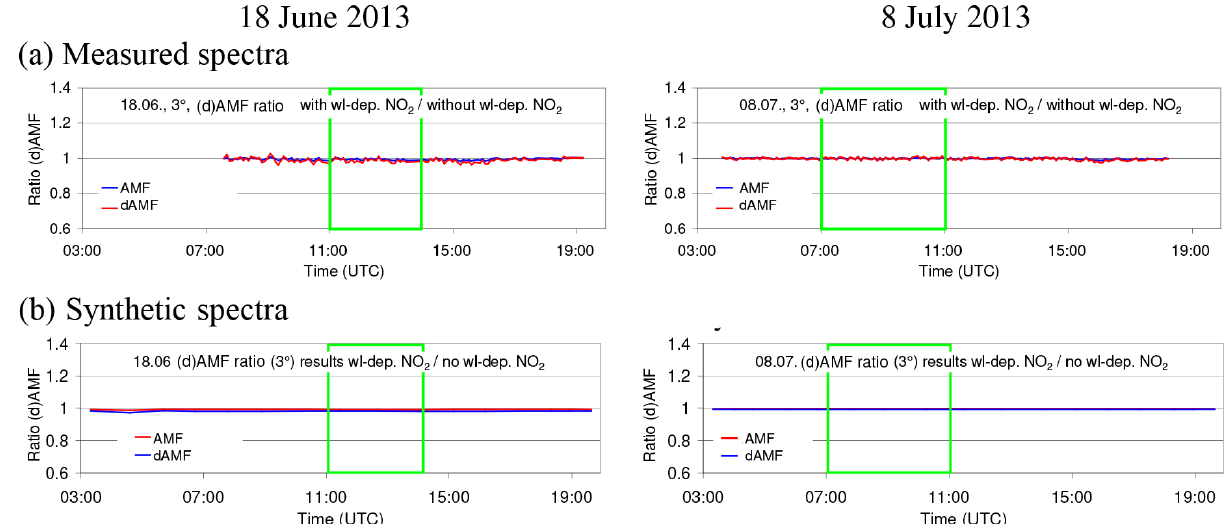
Figure A20. Ratios of the O 4 (d)AMFs derived for the analysis with a second NO 2 cross section (cross section times wavelength) vs. those for the standard analysis (only one NO 2 cross section) for both selected days ( a : results for spectra measured by the MPIC instrument; b : results for synthetic spectra when taking into account the temperature dependence of the O 4 cross section).